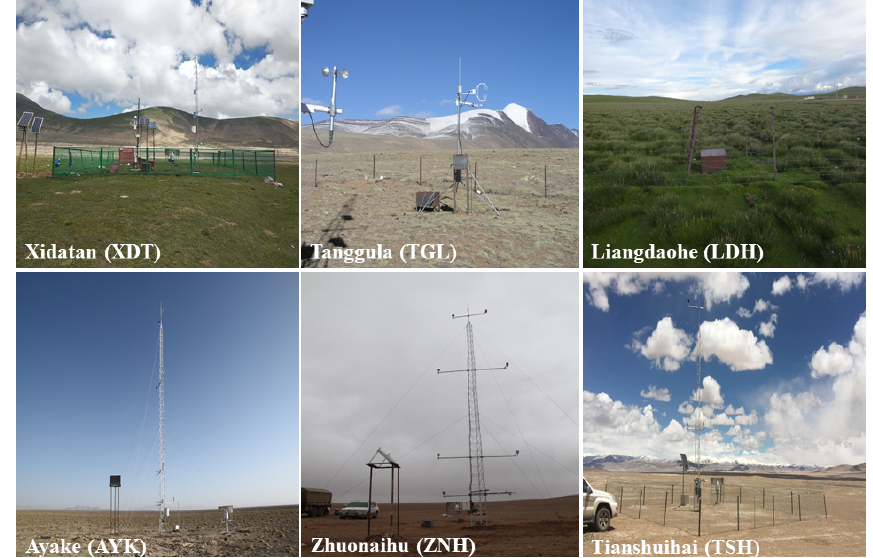
Figure 2. The six comprehensive meteorological stations.